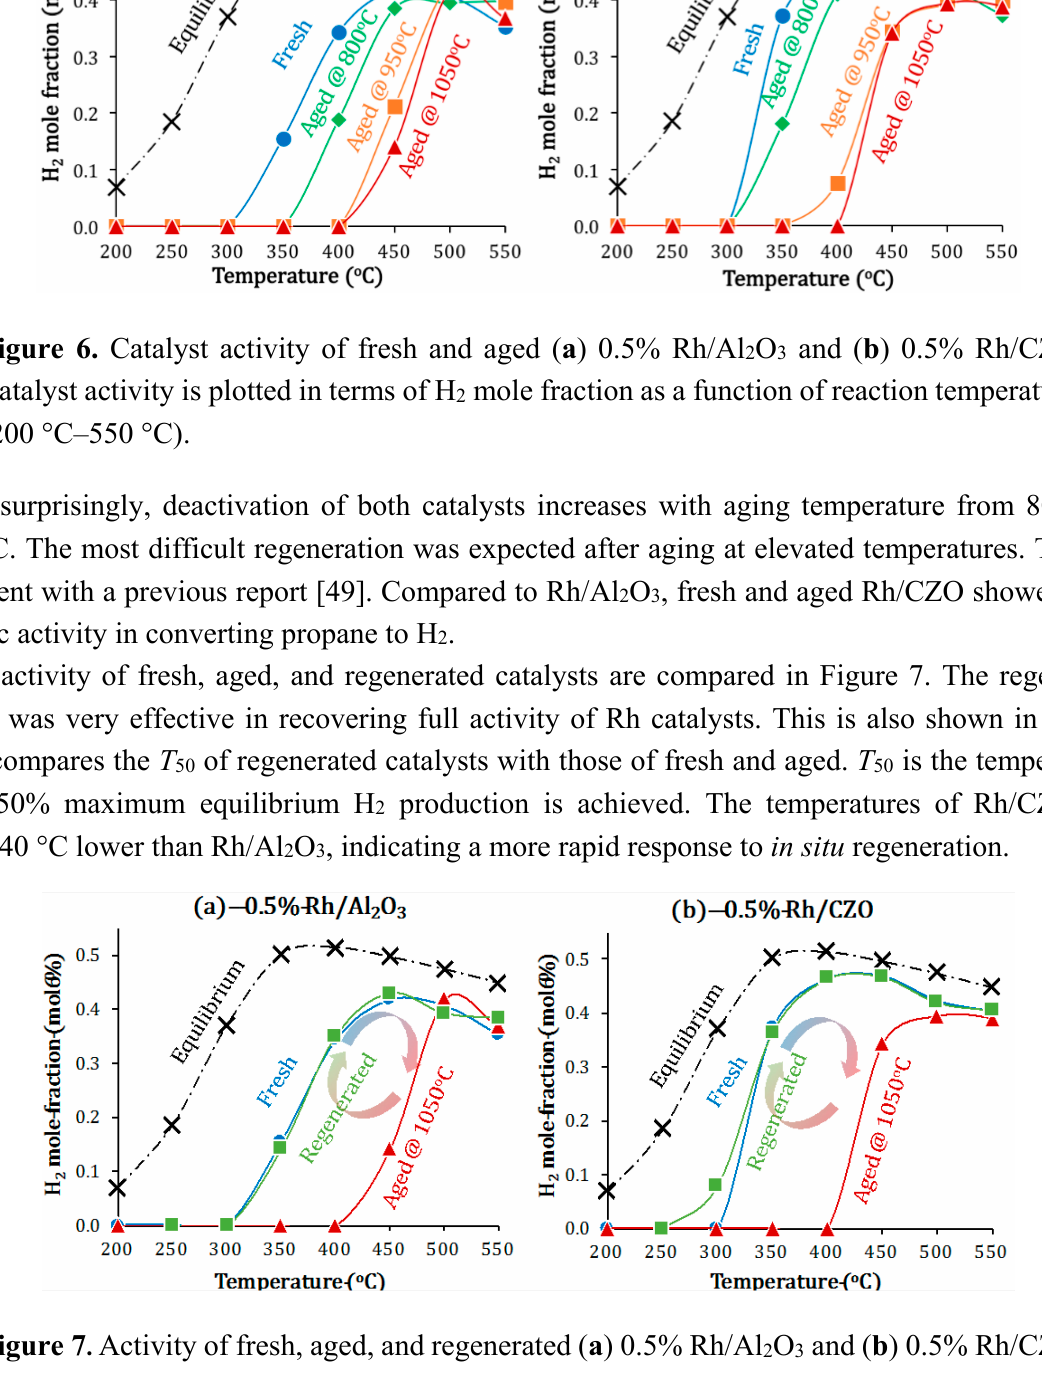
Table 2. T 50 (temperature at which 50% maximum equilibrium H 2 production is reached during activity tests, °C) of fresh, aged, and regenerated